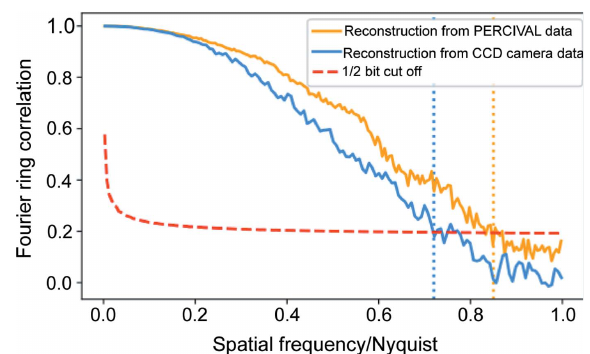
Figure 4 FRC curves calculated from the independent reconstructions shown in Figs. 3( a ) in orange and 3( b ) in blue. The FRC shows a 1.3 (cid:2) improvement of the image obtained from the PERCIVAL detector data, reaching 250